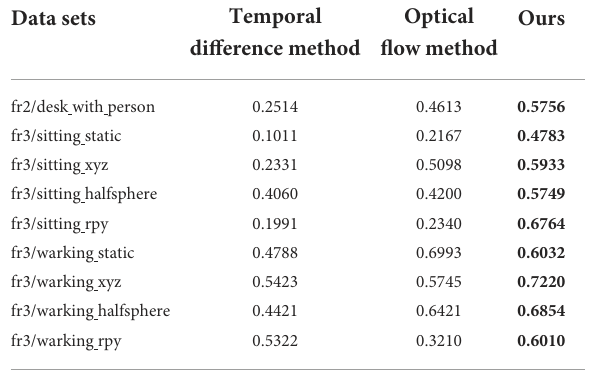
TABLE 1 Dynamic target detection results.